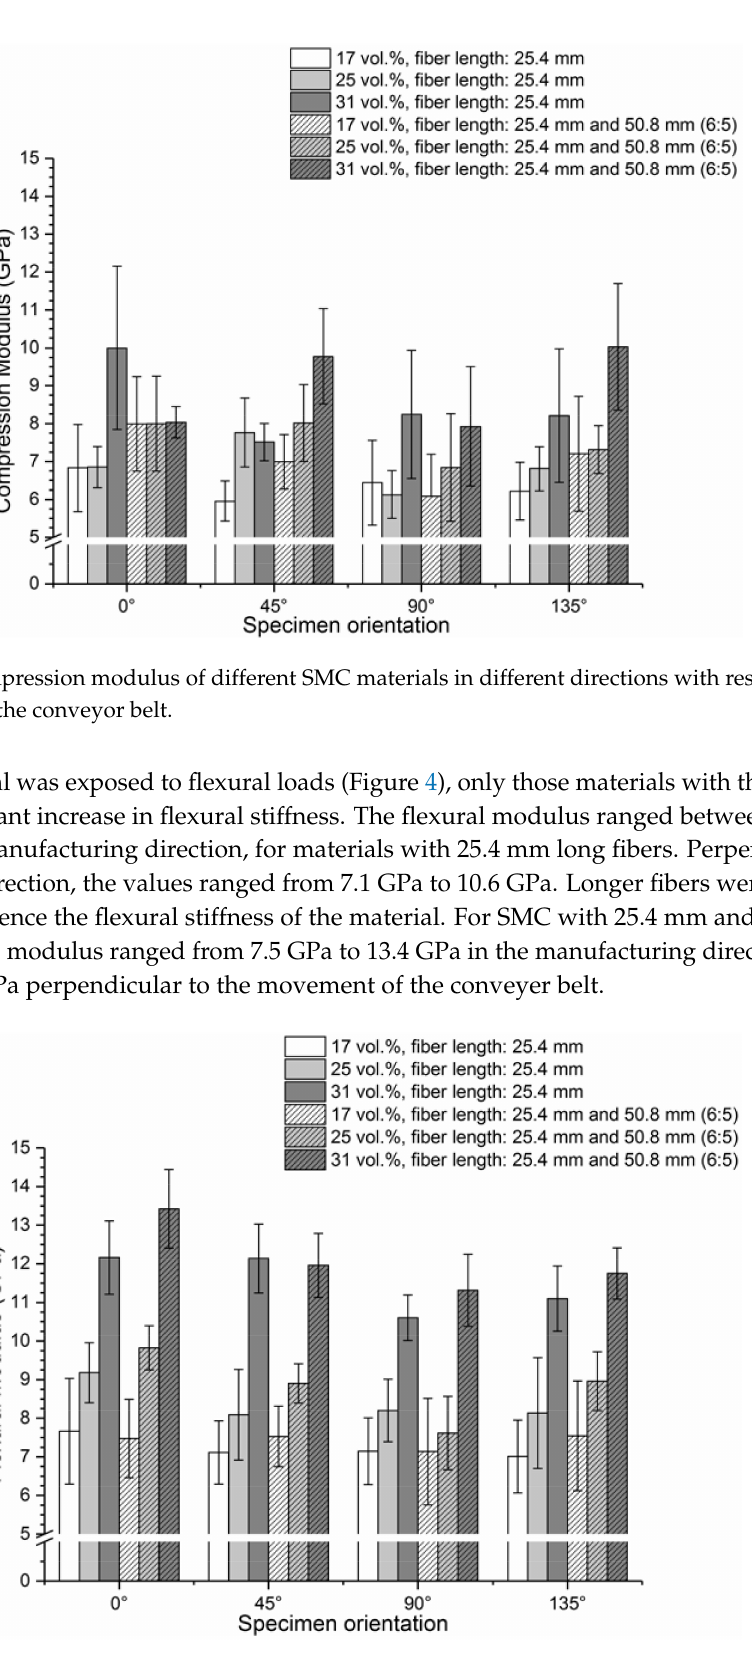
Figure 4. Flexural modulus of different SMC materials in different directions with respect to the movement of the conveyor